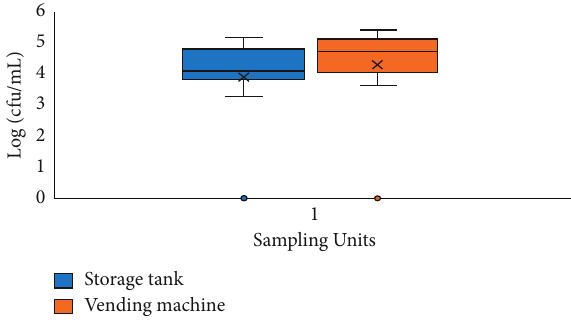
Figure 6: TVC variation in milk from storage tanks and vending